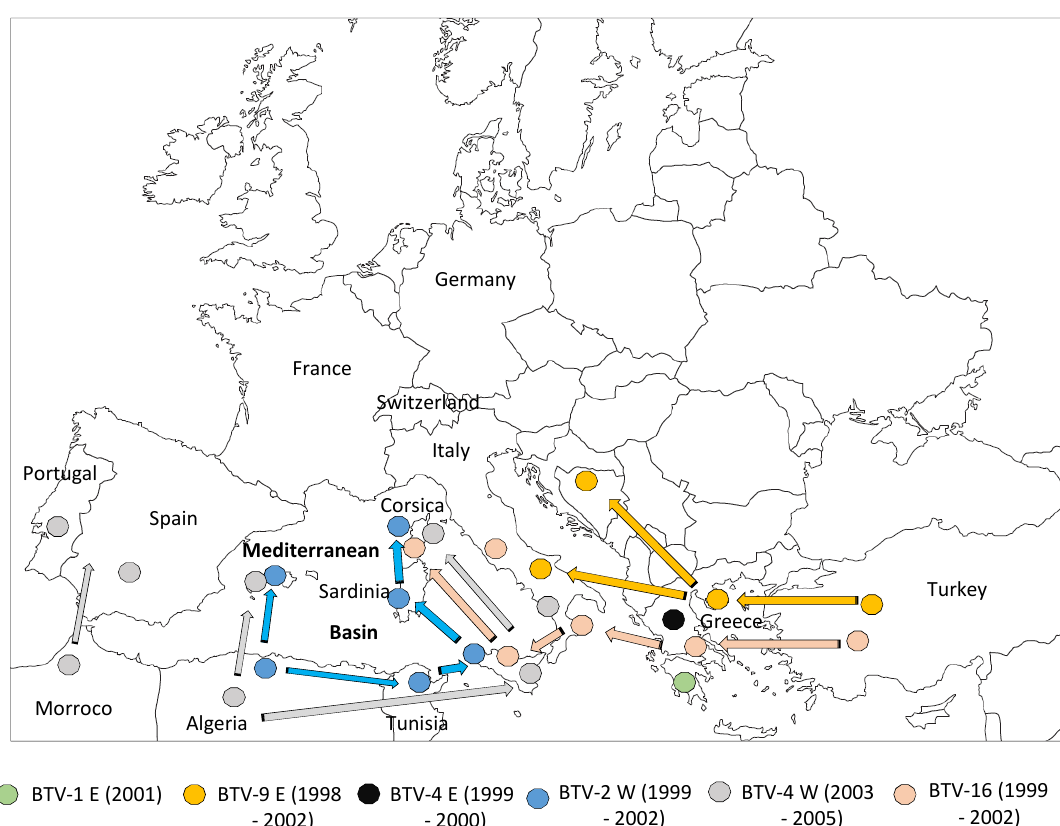
Figure 1. Bluetongue virus (BTV) context from 1998 to 2005. Spread of BTV serotypes and strains (BTV-x) during the period indicated in brackets. E: Eastern strain; W: Western